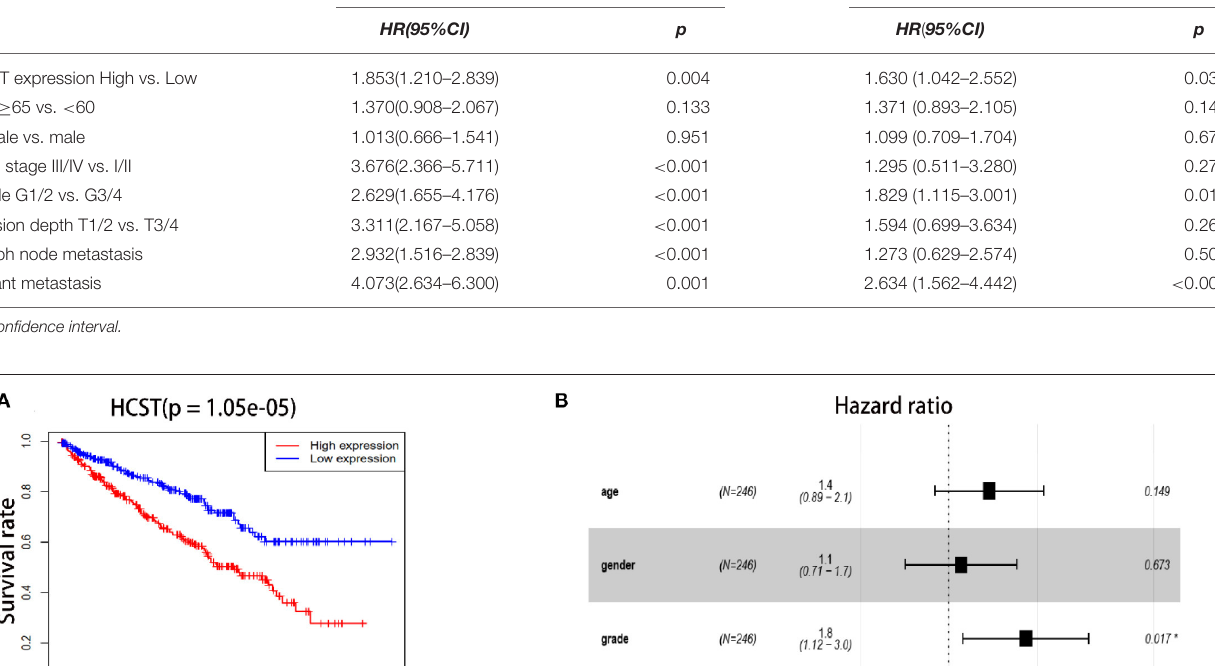
TABLE 2 | Univariate analysis of the prognostic factors in ccRCC patients using a Cox regression model. Parameters OS